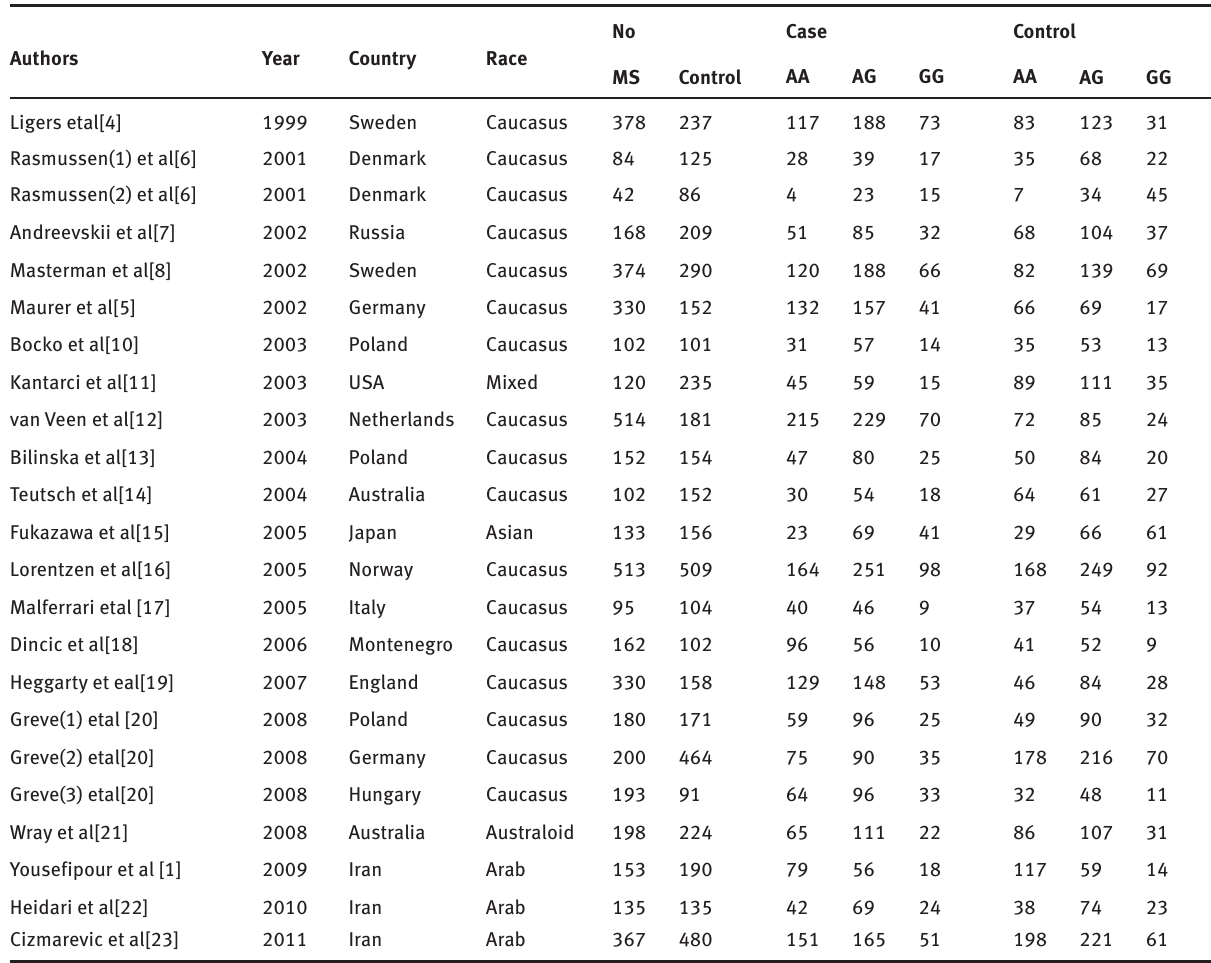
Table 1. General information for the included studies